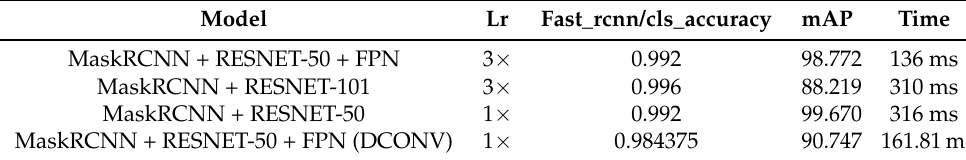
Table 1. Classification accuracy and detection accuracy using mAP with latency.